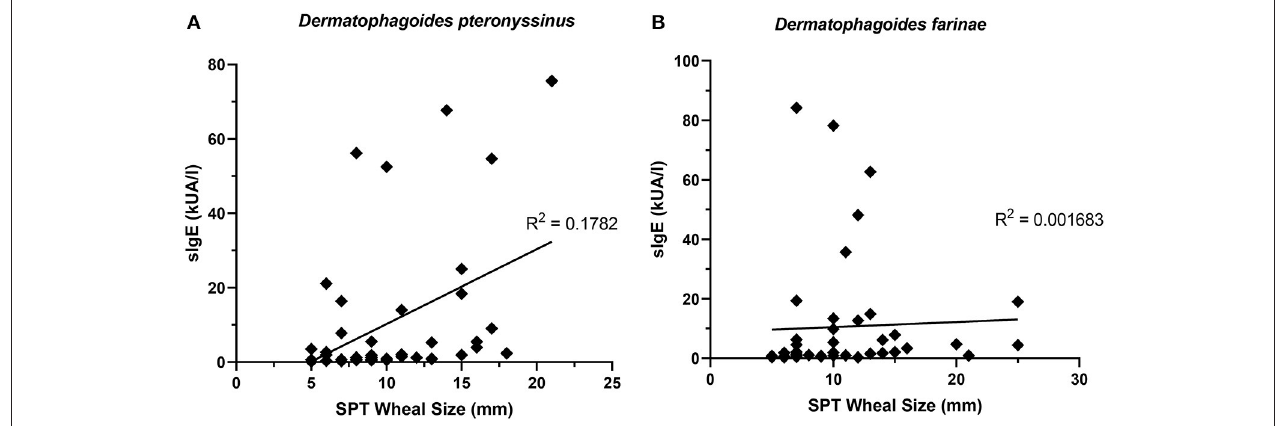
FIGURE 8 | sIgE concentrations and SPT wheal sizes were poorly correlated. SPT wheal sizes and sIgE were poorly correlated for both Dermatophagoides pteronyssinus (A) R 2 = 0.1782 and Dermatophagoides farinae (B) R 2 =